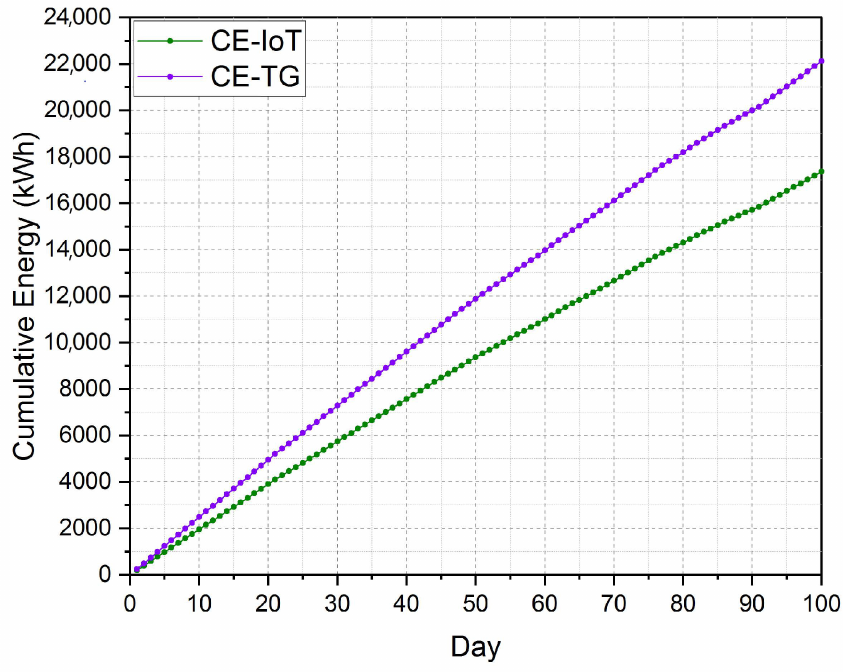
Figure 18. The cumulative electrical energy consumption (kWh/day) of the greenhouse with the established platform (CE-IoT) against the same greenhouse under identical circumstances